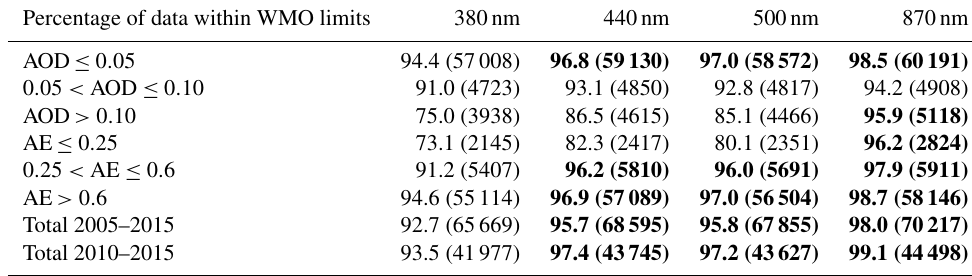
Table 4. Percentage of AERONET-Cimel 1min AOD data (V2) meeting the WMO criteria for the four compared channels and different AOD and AE scenarios for the period 2005–2015. The last row corresponds to the total percentages for the sub-period 2010–2015. AOD and AE traceability > 95% are marked in bold. The number of data pairs is in